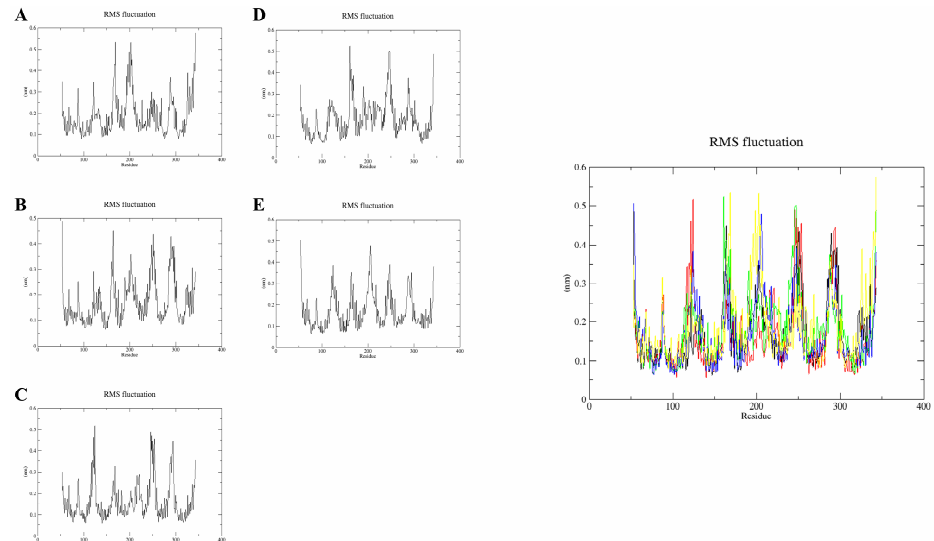
Figure 9. RMSF plot (individual trajectory) of resveratrol ( A ); bisphenol A ( B ); 17 β -estradiol ( C ); G-1 ( D ); G-15 ( E ). RMSF plot (merged trajectories) of resveratrol (yellow); bisphenol A (black); estradiol (red); G-1 (green); G-15 (blue).